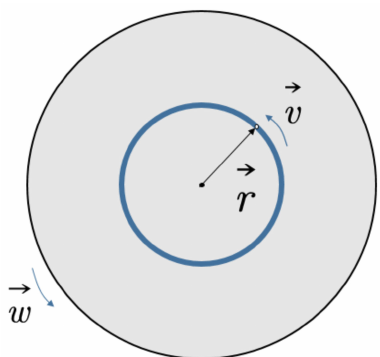
Figure 6. Schematic diagram of jet velocity under centrifugal action.